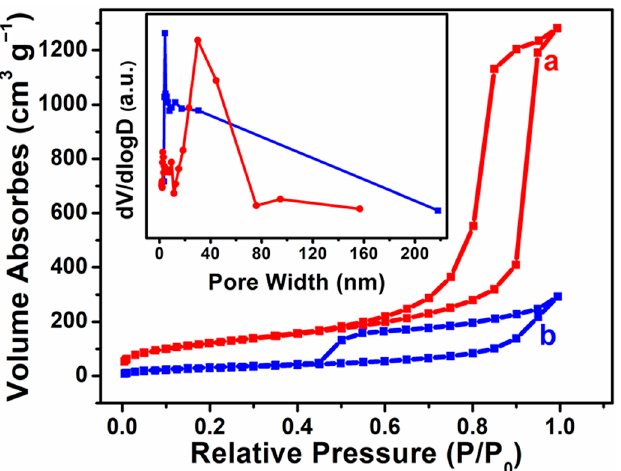
Figure 3. Nitrogen adsorption–desorption isotherms for MCF (a) and heteropolyacid ionic liq- uid-based MCF (b). Inset: Pore size distribution plots of MCF (red) and heteropolyacid ionic liquid-based MCF (blue).